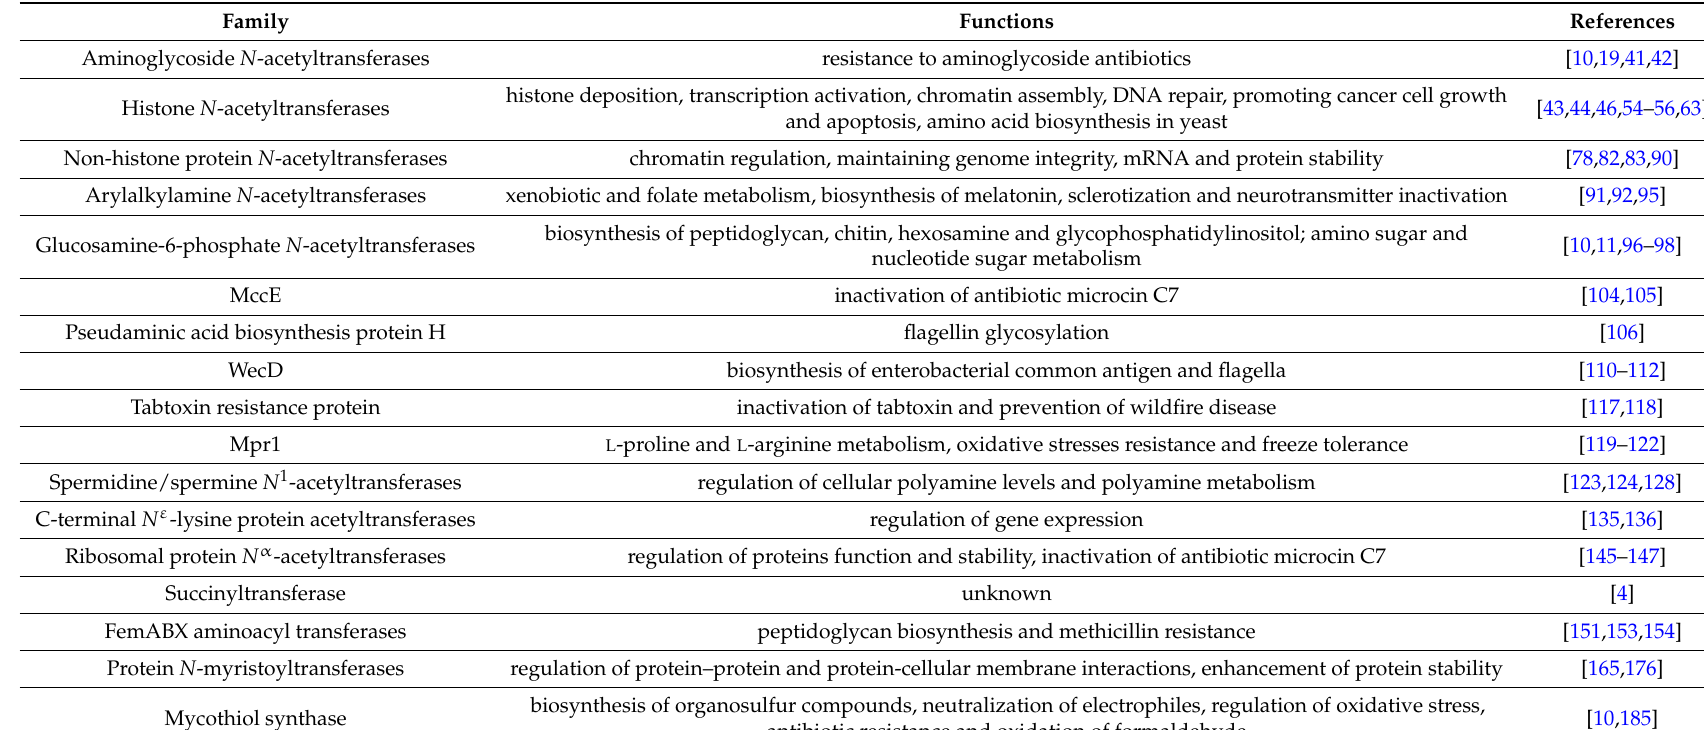
Table 2. Functions of GNAT superfamily